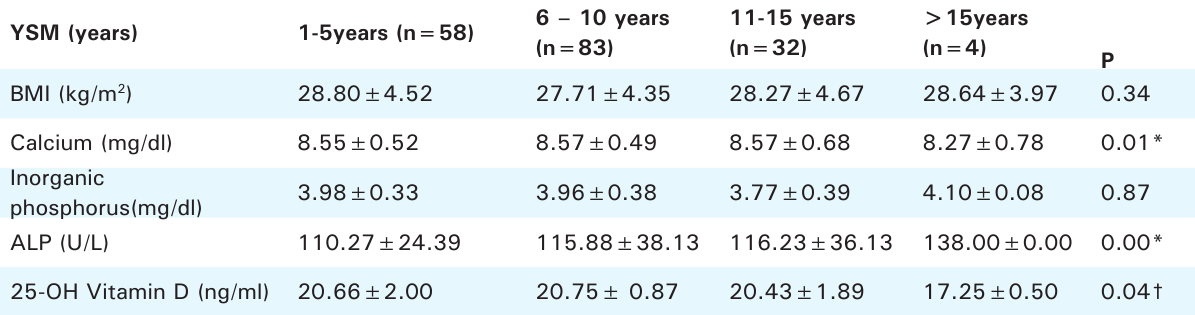
Table 2. Comparison of YSM with BMI, serum calcium, serum inorganic phosphorus, serum alkaline phosphatase and Vitamin D level among post-menopausal women (n=177).